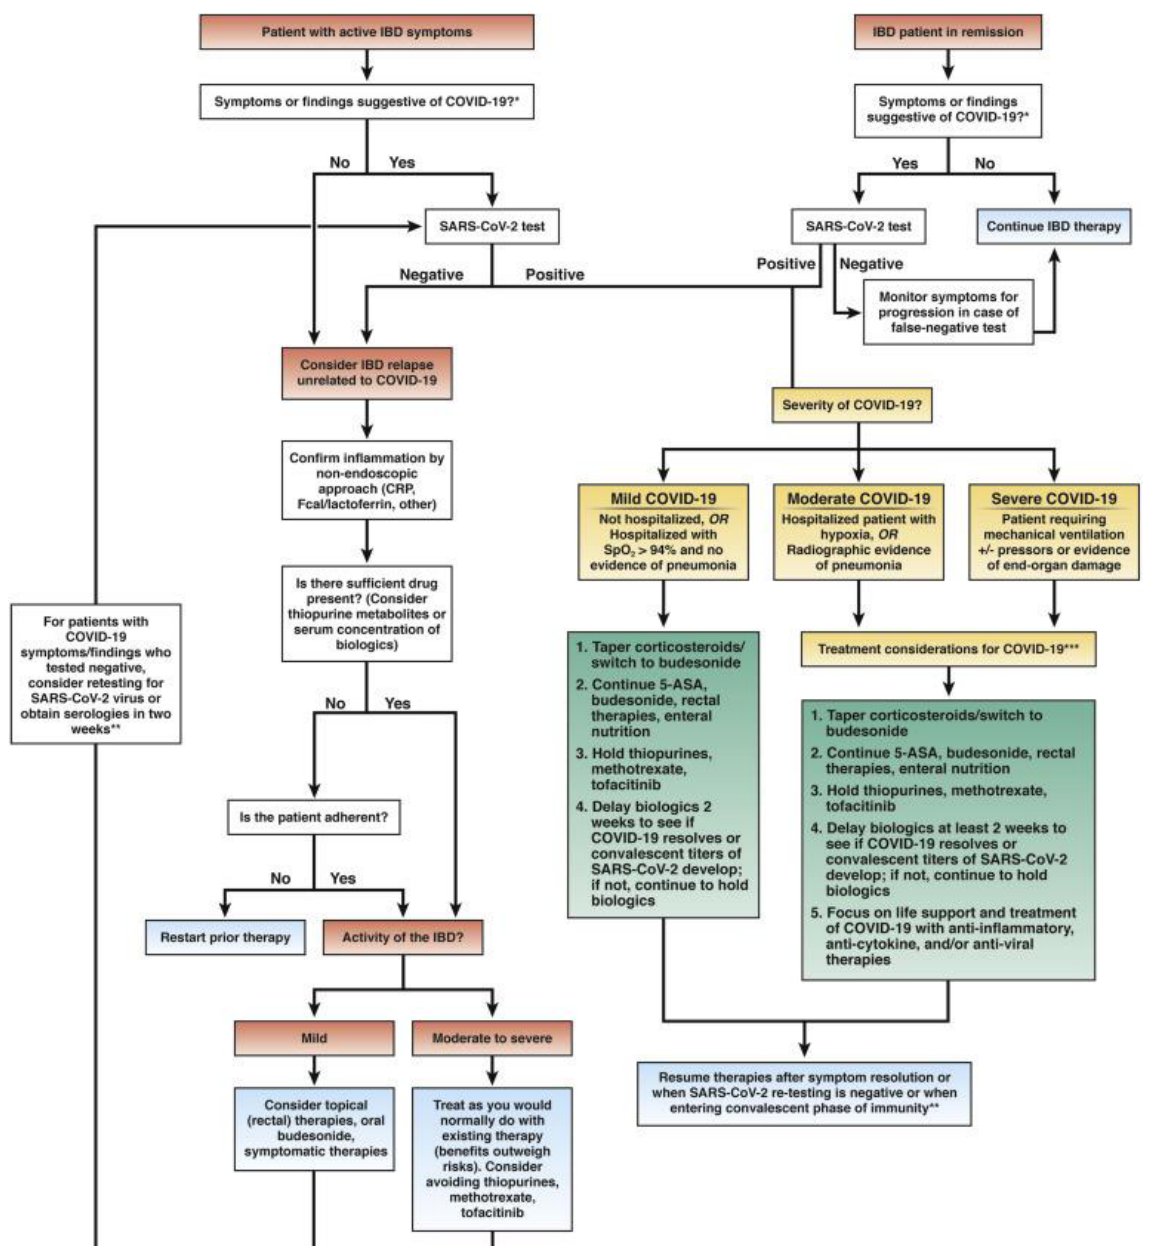
Figure 2. Management of patients with IBD during the COVID-19 pandemic. 5-ASA, 5-aminosalicylic acid medication; CRP, C-reactive protein; mAb, monoclonal antibodies. * Symptoms and consequences of COVID-19: fever (83 – 99%); cough (59 – 82%); fatigue (44 – 70%); anorexia (40 – 84%); shortness of breath (31 – 40%); sputum production (28 – 33%); myalgias (11 – 35%); headache, confusion, rhinorrhea, sore throat, hemoptysis, vomiting, and diarrhea (<10%); lymphopenia (83%); computed tomography chest: bilateral, peripheral, ground-glass opacities [103]. ** Clearance of SARS-CoV-2 may enable the resumption of IBD therapy; the role of serologic antibody testing is unclear at the current time. *** Indicating new a sentence. Viral clearance testing may or may not be possible or appropriate, given local testing capabilities and health system-approved epidemiological testing strategies during the COIVD-19 pandemic. Treatments for COVID-19 are under investigation, considering therapies that have safety and efficacy in IBD. Reprint /Doneadapted with permission from Rubin et al. Ref. [10].